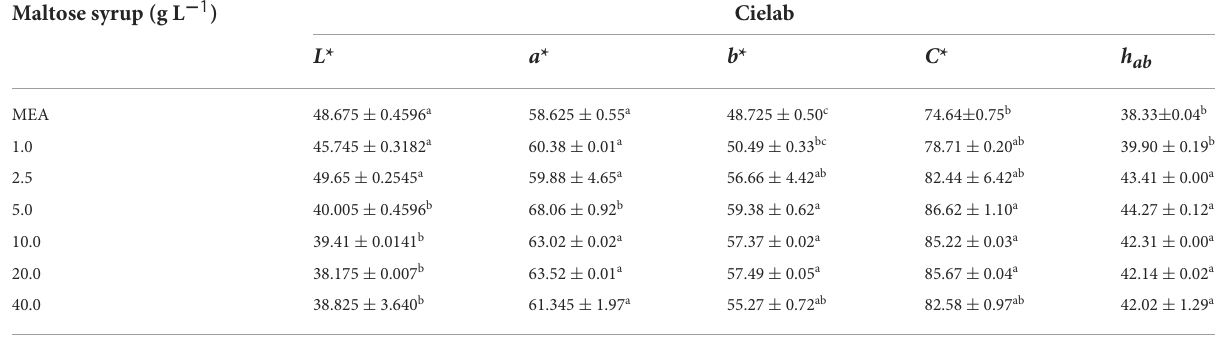
TABLE 3 Mean and standard deviation of the colour parameters of the pigments produced by Monascus ruber CCT 3802 grown in different concentrations of maltose syrup. − 1 Maltose syrup (g L